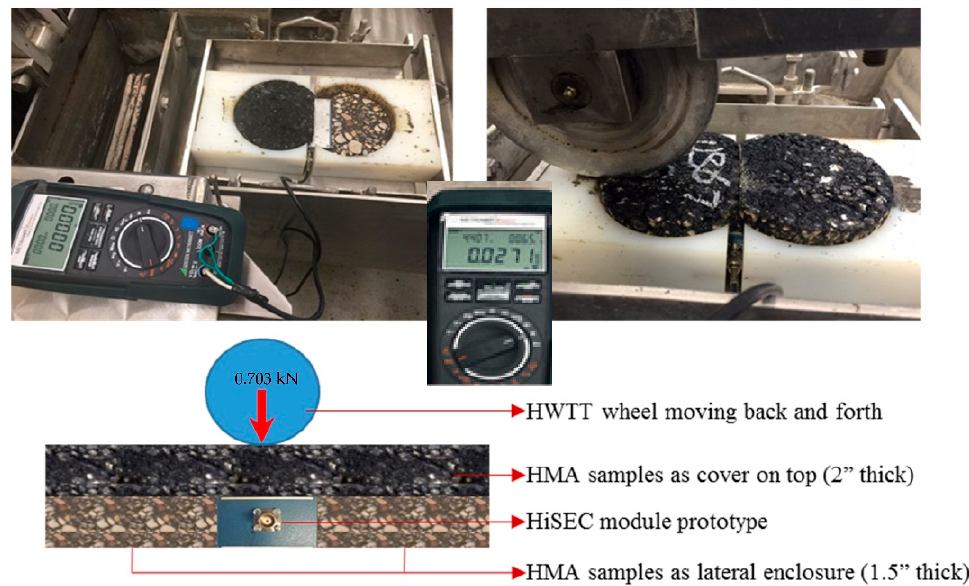
Figure 3. The HWTT Loading Configuration and HiSEC Module Setup.